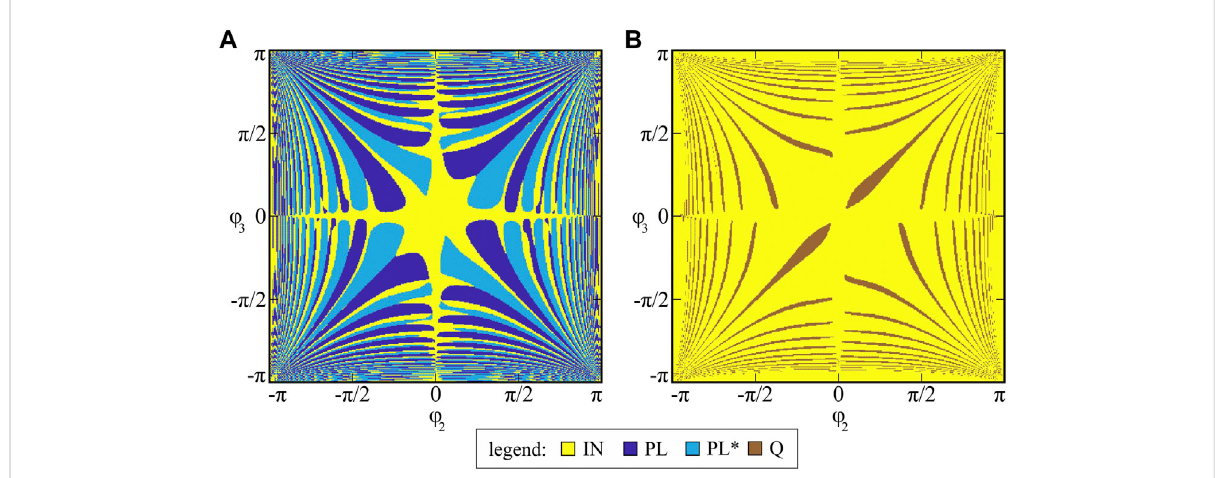
FIGURE 4 (Colour online). The basins of attraction for different distribution of the pendula masses. In (A) the scenario of three co – existing periodic synchronous states is shown (IN: in – phase state, PL: the fi rst phase – locked state and PL*: the second phase – locked state), while in (B) the case of bi – stability of the in – phase (IN) and the quasiperiodic (Q) con fi gurations is presented. The values of the masses in panels (A) and (B) correspond to the ones considered in Figure 3B and Figure 3C, respectively. The results show, that depending on the initial conditions, various types of behaviours co –